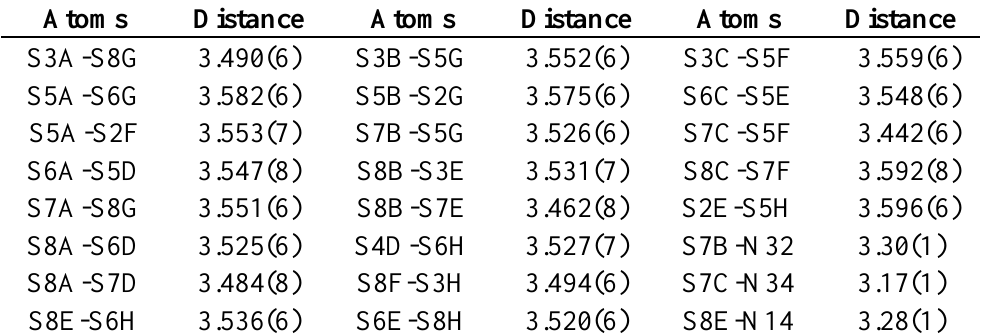
Table 7. Intermolecular S···S and S···N distances (in Å) shorter than the sum of the van der Waals radii (3.60 and 3.35 Å, respectively) in compound 3 .